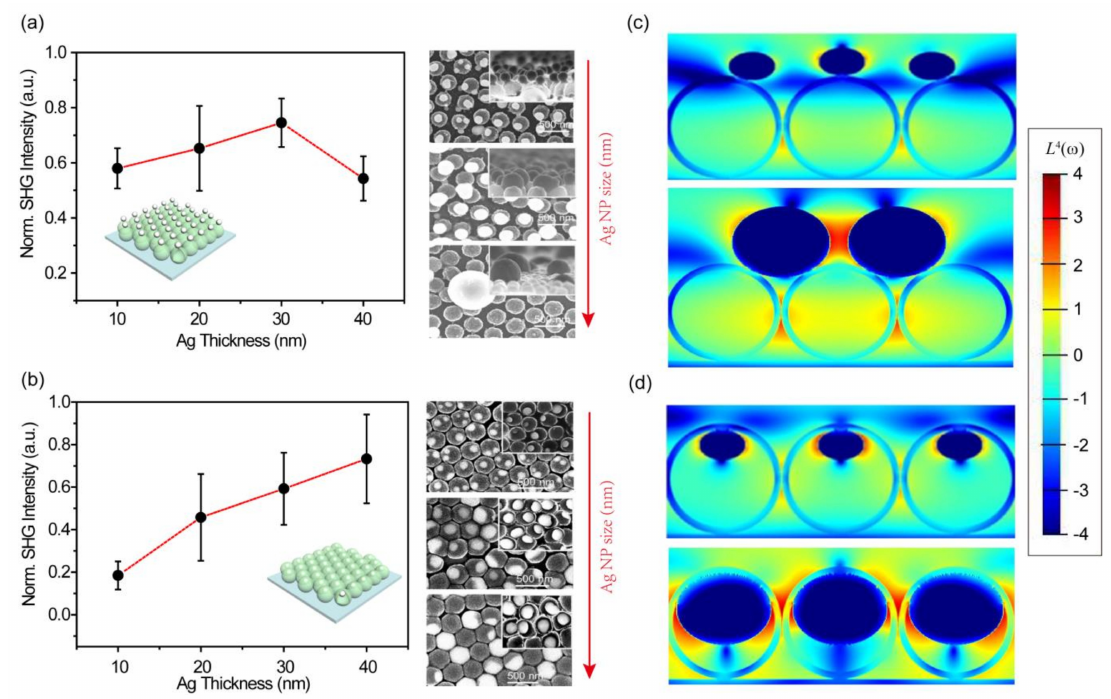
Figure 5. ( a ) Ag-NP dependent PESHG performances for SZCA(10), SZCA(20), SZCA(30), and SZCA(40) at a given power value (P = 1.4 mW). Insets: Ag-NP dependent SEM images of SZCA(10), SZCA(30), and SZCA(40), respectively. The red arrow refers to the trend of the coarsening of the AgNP size both in SZCA and ZSCA. The data in ( a ) are normalized by the maximum value of SZCA(30). ( b ) Ag-NP dependent PESHG performances for ZSCA(10), ZSCA(20), ZSCA(30), and ZSCA(40) at a given power value (P = 1.4 mW). Insets: Ag-NP dependent SEM images of ZSCA(10), ZSCA(30), and ZSCA(40), respectively. The data in ( b ) are normalized by the maximum value of ZSCA(40). Error bars in ( a , b ) denote the deviation of the average signal intensity through multiple acquisitions from three different spatial positions of the same sample. The red dashed lines are to guide the eyes. Simulated near-field distributions of ( c ) ZSCA(10) and ZSCA(30); ( d ) SZCA(10) and SZCA(30) were excited by an 800-nm pumping wavelength in logarithmic scale. All data are